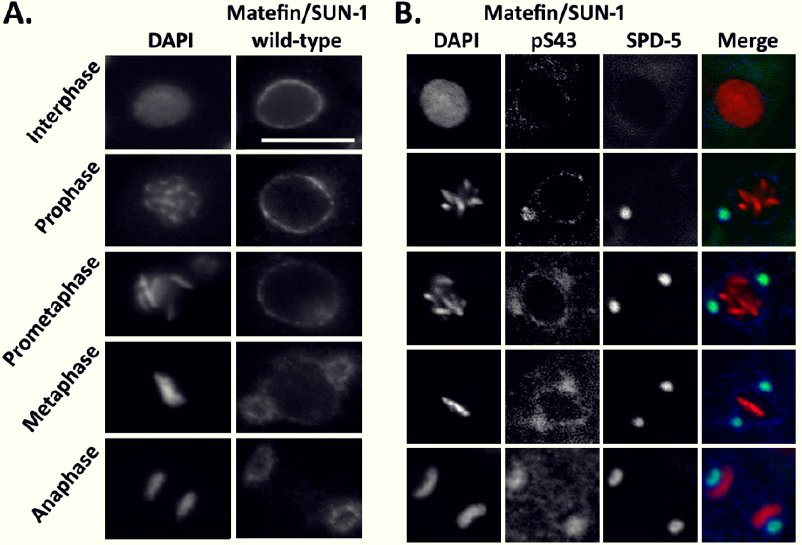
Figure 1. Matefin/SUN-1 pS43 localizes to centrosomes. ( A ) wild-type matefin/SUN-1 and ( B ) matefin/SUN-1 pS43 ( blue ) co-localize with the centrosome marker SPD-5 ( green ) during the different stages of cell cycle (DNA indicated in red ). Scale bar 10 μ m.